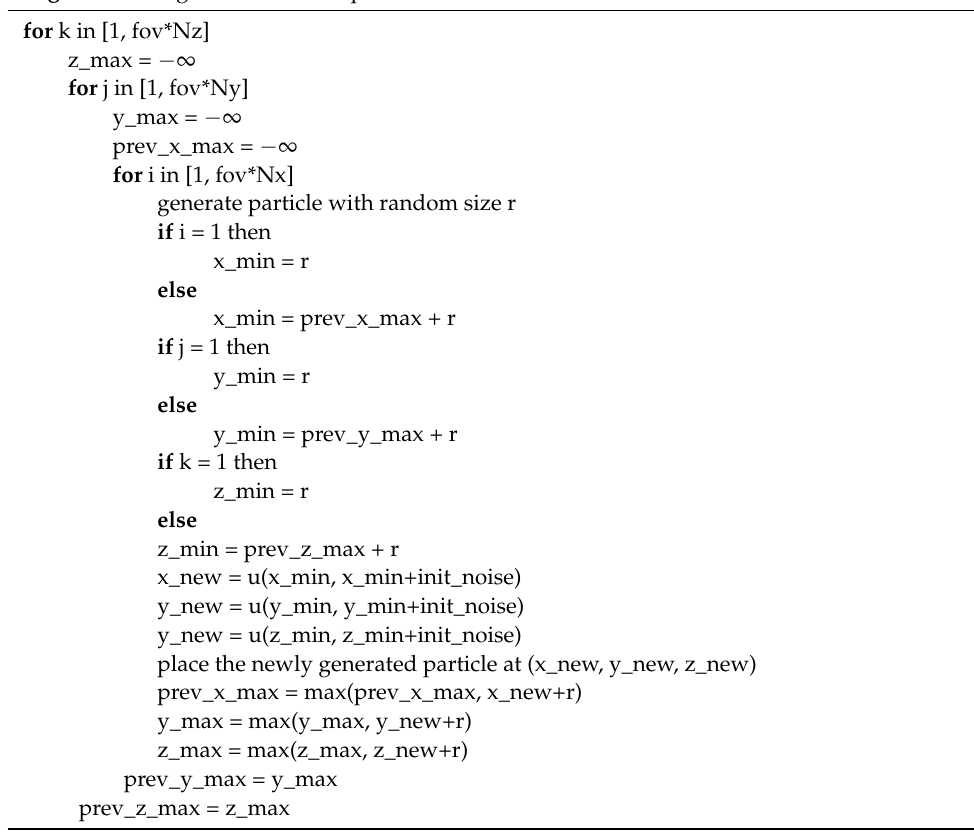
Algorithm 1 Algorithm of initial position